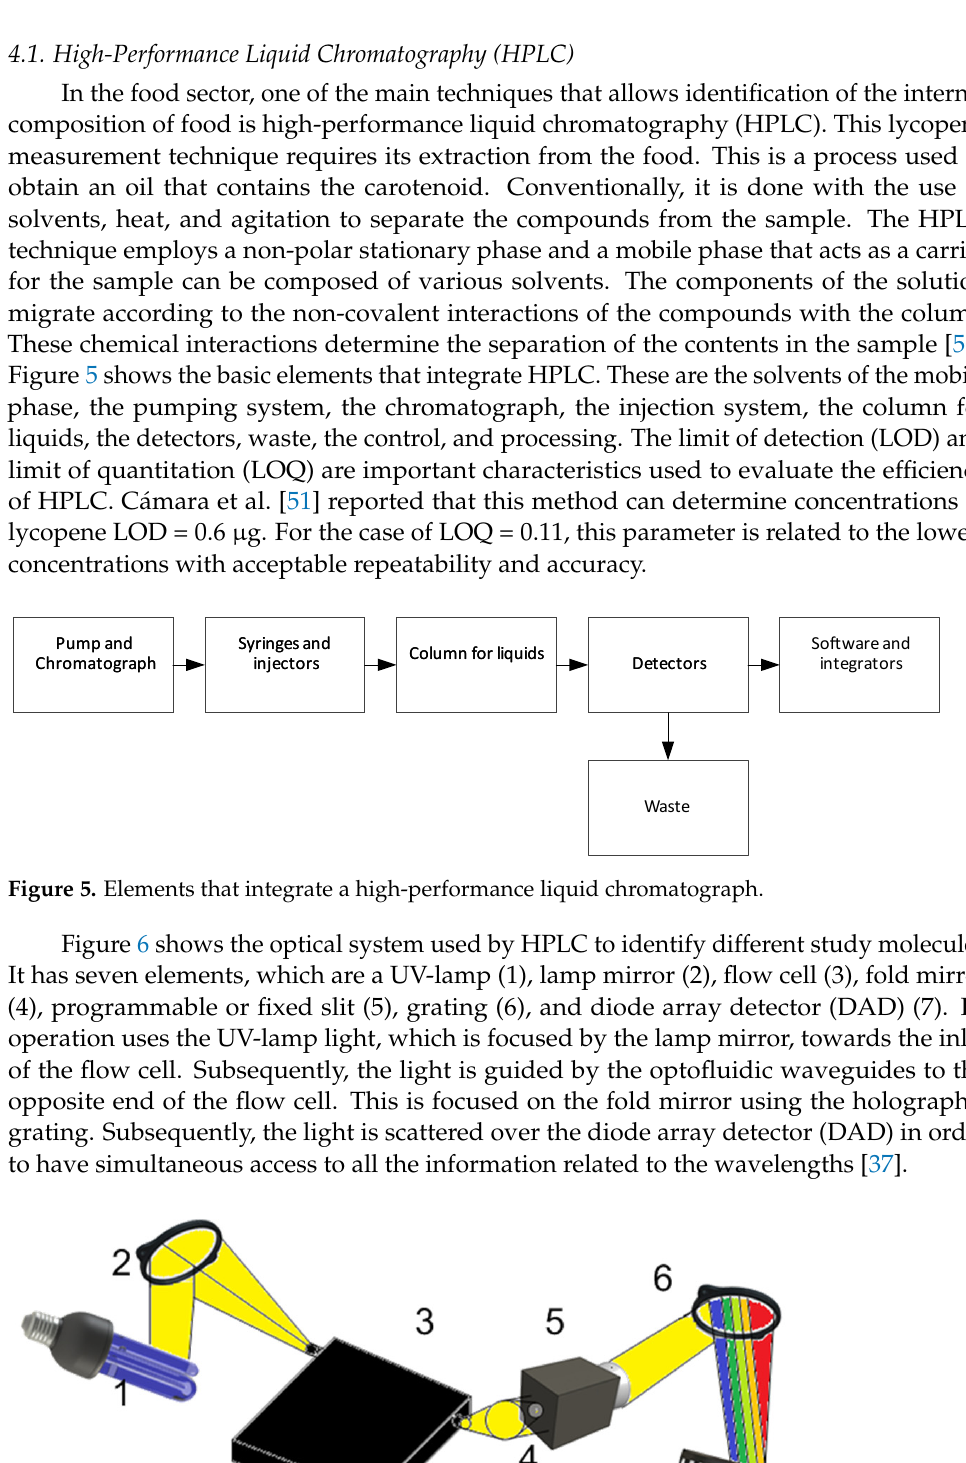
Figure 6. Elements that integrate the optical system of HPLC [37].